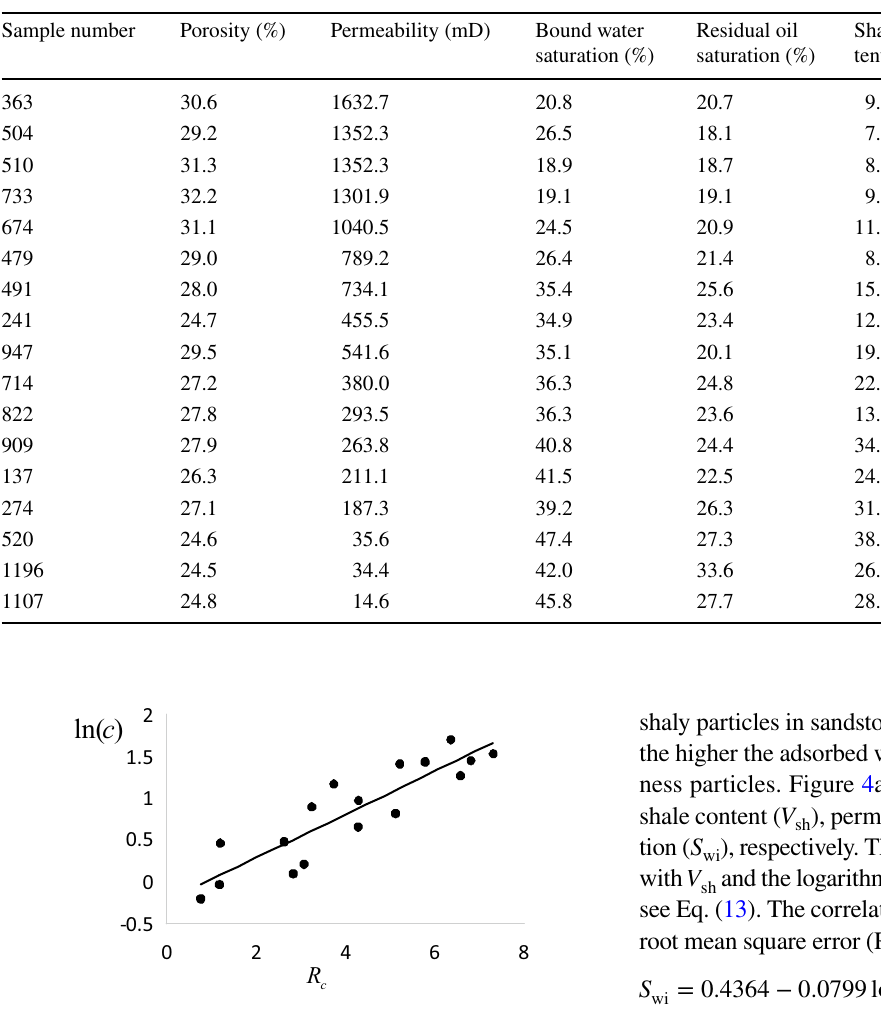
Fig. 2 Correlation diagram between R c and ln ( c ) of 17 samples